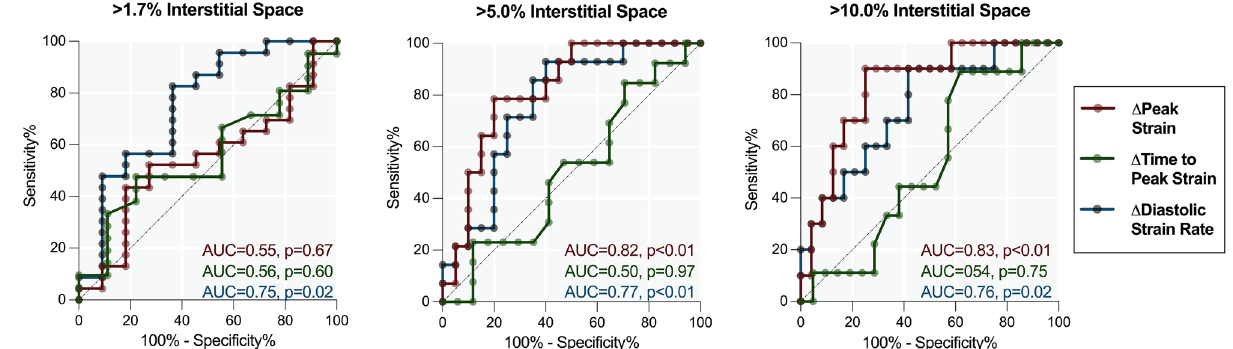
Figure 4. Ability of CMR feature tracking to discriminate incremental increases of LV interstitial space. Receiver operating curves demonstrate the area under the curve of the regional diastolic and systolic feature tracking strain measurements in comparison to localized samples assessed histologically for interstitial space. Analysis was performed using three cut-offs increasing with more severe myocardial injury.